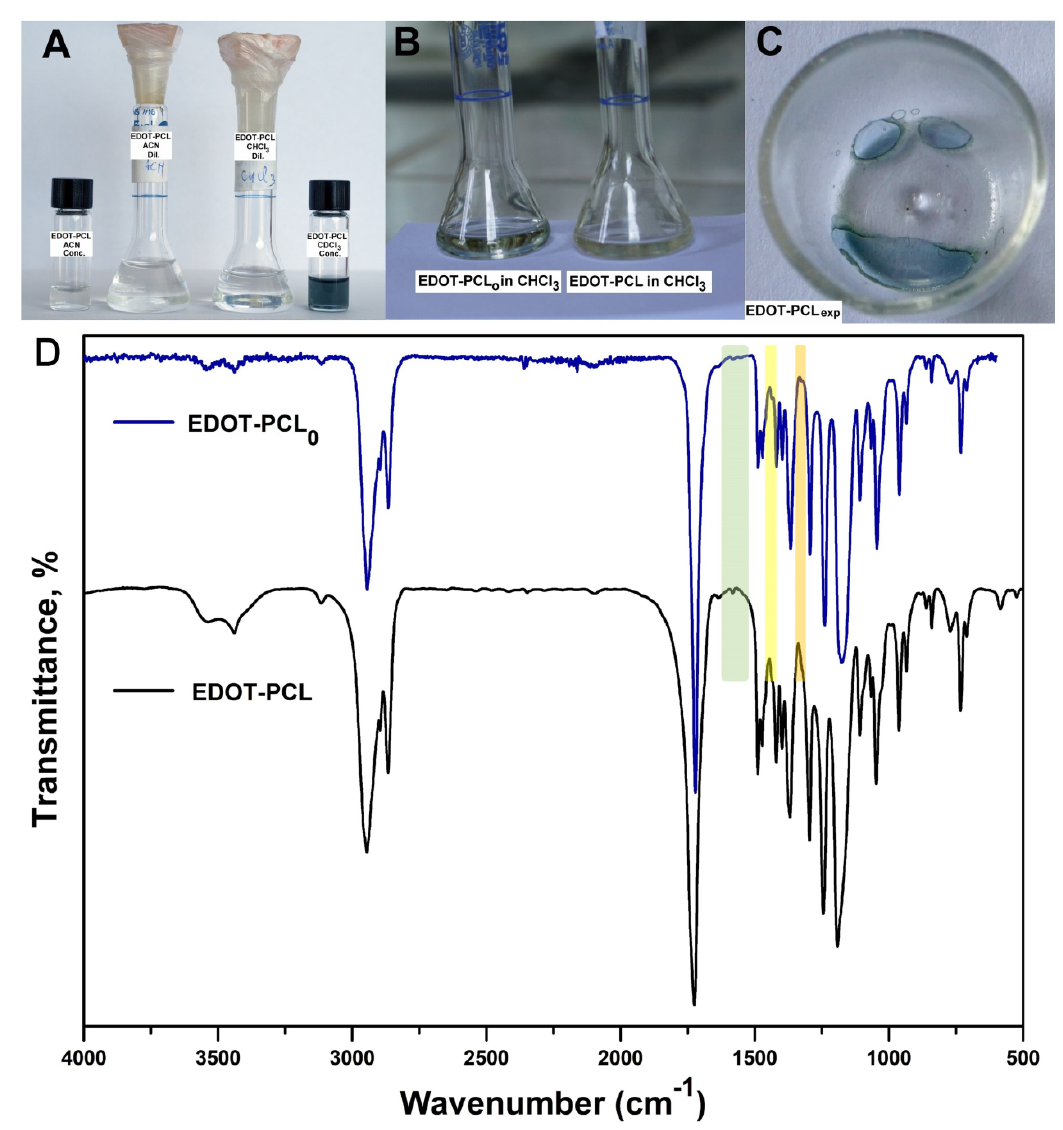
Figure 6. ( A ) (From left to right): the EDOT-PCL in an ACN concentrated solution, in an ACN diluted solution, diluted EDOT-PCL in Chl, and very concentrated CDCl 3 solution of EDOT-PCL ; ( B ) EDOT-PCL o and EDOT-PCL in the Chl-concentrated solution; ( C ) blue film layer appeared after evaporation of the chloroformic solution of EDOT-PCL treated with hydrochloric acid (HCl) ( EDOT-PCL exp ); ( D ) FT-IR spectra of EDOT-PCL and EDOT-PCLo .